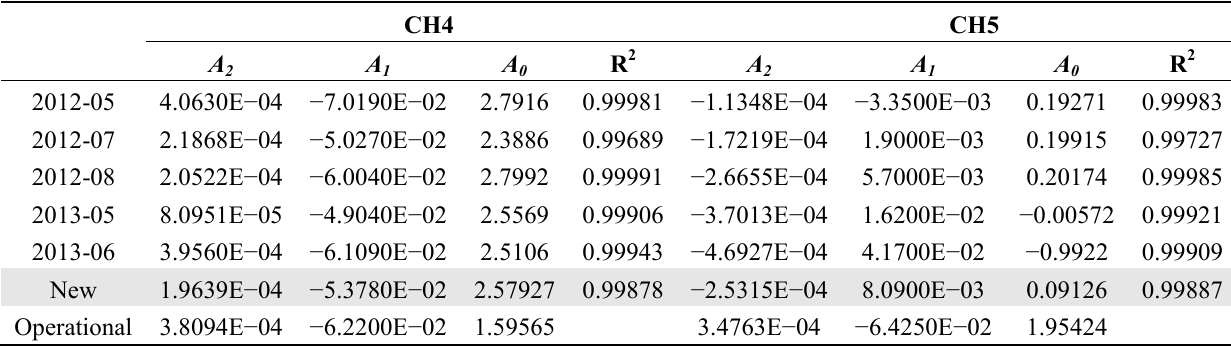
Table 1. Comparison of nonlinear correction coefficients of FengYun-3 (FY-3A) Visible Infrared Radiometer (VIRR) calculated using collocation samples during different